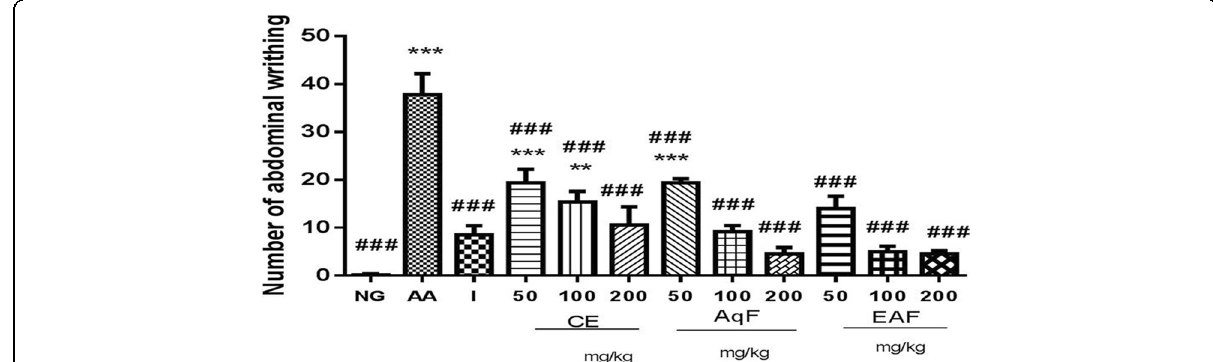
Fig. 7 Antinociceptive effects of the Indomethacin, CE and fractions (50, 100 or 200 mg/kg) of E. uniflora Linn at various doses on the number abdominal contortions observed following the administration of acetic acid. Data are expressed as the mean ± standard mean error ( n =5). An test was used to calculate statistical significance, *** p <0.001 versus the normal control; ### p <0.001 versus the Acid Acetic. NG (normal control group), AA (acetic acid), I (indomethacin), CE (crude extract), AqF (aqueous fraction), EAF (ethyl acetate-treated